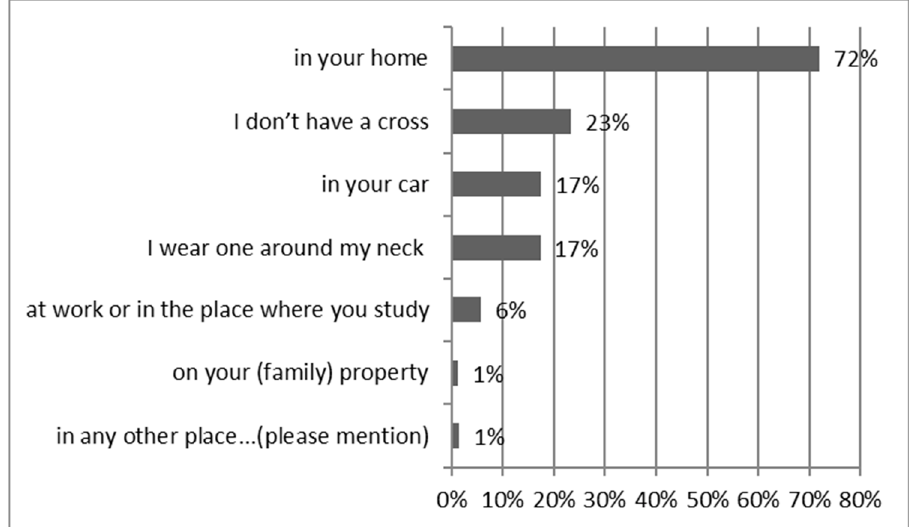
Figure 2. Do you own any kind of a cross, meaning an object in the shape of a cross, no matter what size? (mark all that apply). Source: Results based on a survey (CAPI) carried out on a nationwide sample of N = 1002 Poles aged 18+.